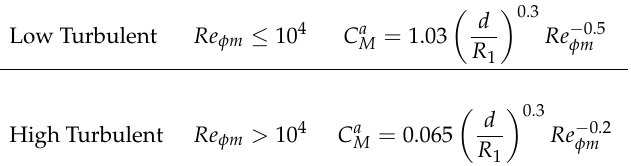
Table 1. Moment coefficient on the cylinder for the In housing configuration.